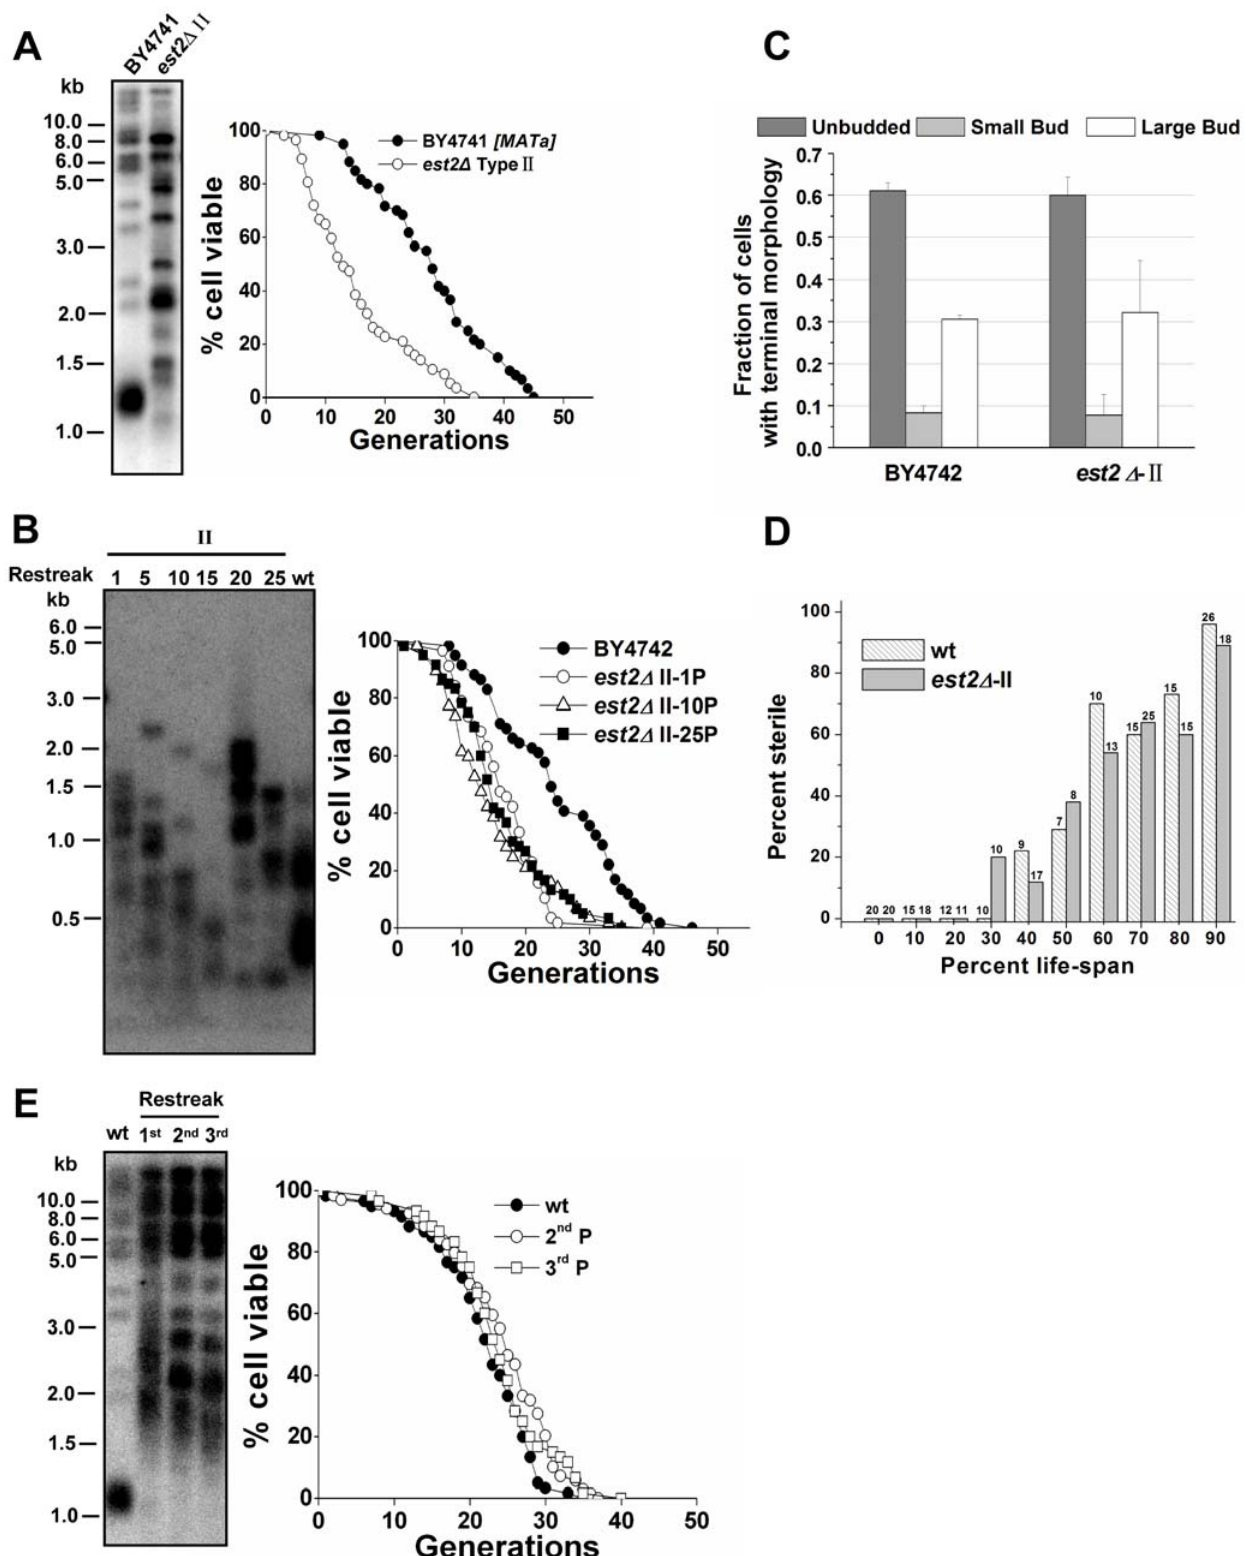
Figure 2. Premature aging of telomerase-null type II survivors. (A) Telomere analysis (left) and life span assay (right) of telomerase-null type II survivors. The number of daughter cells (generations) produced per mother cell are plotted as a function of mother cell viability. Average life span of strains shown (sample size): BY4741, 27.8 6 9.7 (n=60); est2 D -type II ( MATa ), 15.3 6 8.5 (n=57). (B) Changes of telomeres (left) and life span (right) in type II survivors during the outgrowth. Type II survivors were serially restreaked 25 times on YPD plates. (Left) Genomic DNA from the 1 st , 5 th , 10 th ,